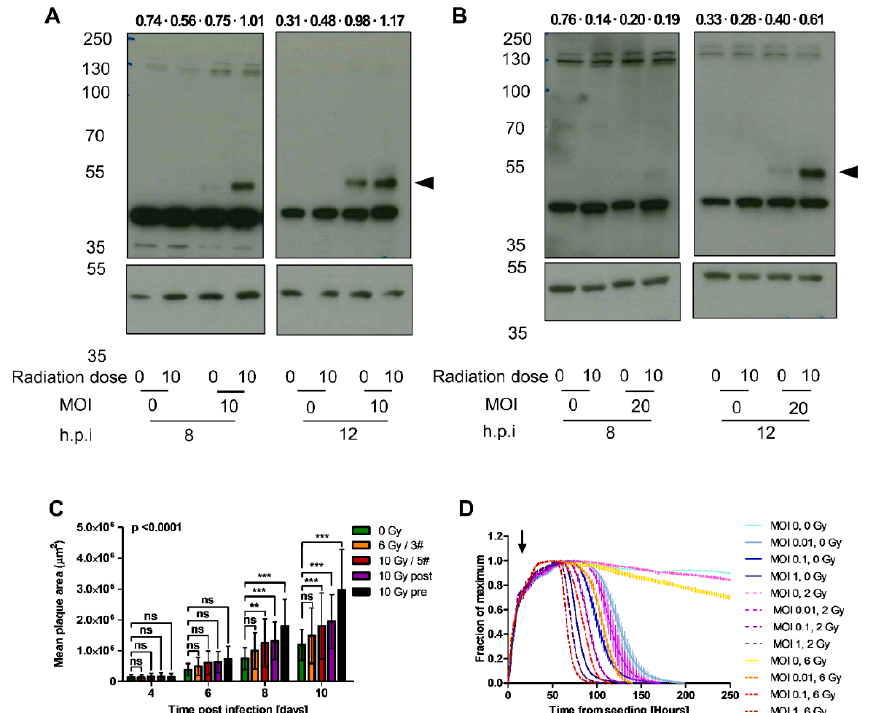
Figure 2. Irradiation increases EnAd particle production and cytotoxicity. ( A ) A549 or ( B ) HCT116 cells were irradiated at 10 Gy and seeded after eight hours. Cells were infected with EnAd E1a-FLAGtag 24 h post-irradiation at an MOI of 0 or 10 ( A ) or an MOI 0 of 20 ( B ). At eight hours and twelve hours post-infection, 70 µg of cell lysates were harvested and probed using an anti-FLAG antibody or β -actin (loading control). Arrows indicate bands of interest. Density for each band is given above the corresponding lane as a β -actin-corrected value. ( C ) A549 cells were pre-irradiated at 10 Gy or 0 Gy at 18 h prior to seeding into 6-well plates at 1 × 10 6 cells / well. At 6 h post-seeding, cells were infected with EnAd-SA-GFP virus with 0.0001 VP / cell for three hours before overlaying with agarose. At 24 h p. i., cells were either mock-irradiated (for pre-irradiated wells) or irradiated at 10 Gy (“10 Gy post”) or 2 Gy (“10 Gy / 5#” and “6 Gy / 3#”). Samples marked “6 Gy / 3#” were irradiated with a further 2 Gy at 3 and 5 days p. i. Samples marked “10 Gy / 5#” were irradiated with 2 Gy at 3, 5, 7 and 9 days p. i. All plates were imaged and analysed using a Celigo imaging cytometer at 4, 6, 8 and 10 days p. i. Data represent biological quadruplicates ± SD from a single experiment representative of two repeats. ( D ) A549 cells were irradiated at 2 or 6 Gy or mock-irradiated at 8 h prior to seeding at 2 × 10 4 cells / well in E-plates. At 24 h post-irradiation, cells were mock-infected or infected with EnAd-SA-GFP at an MOI of 0.01, 0.1 or 1 (arrow). All conditions were plated in quadruplicate and electrical impendence measured as a model of cell death; outer wells were excluded from analysis. Data represents mean values of biological triplicates ± SD for each sample group compared to the maximum cell index. Significance was evaluated using two-way ANOVA with Bonferroni post-test. ** p < 0.01, *** p < 0.001.